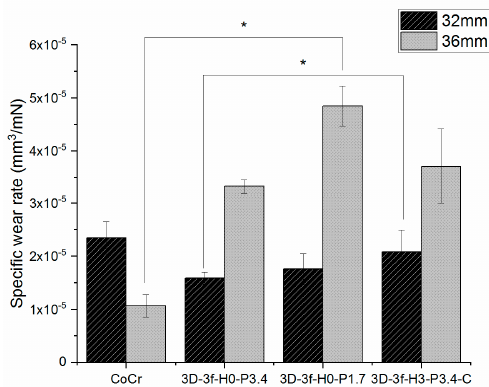
Figure 3. Specific wear rate of PE discs against 32 mm and 36 mm full head implants. * indicates a statistically significant difference between groups.